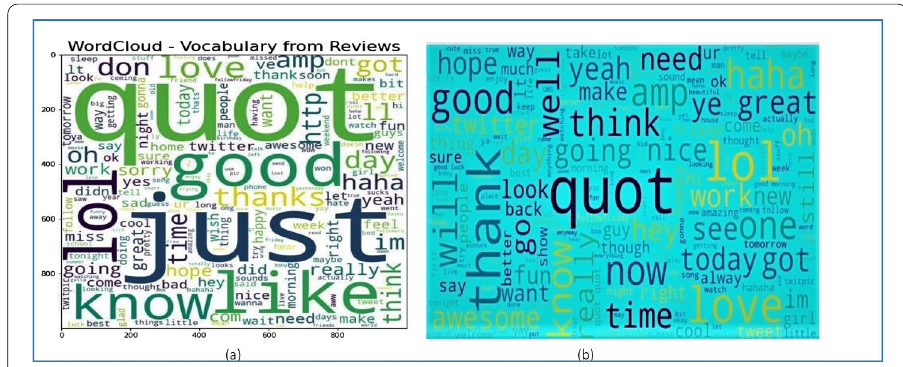
Fig. 9 WordCloud ( a ) top 30 words ( b ) most recurring positive